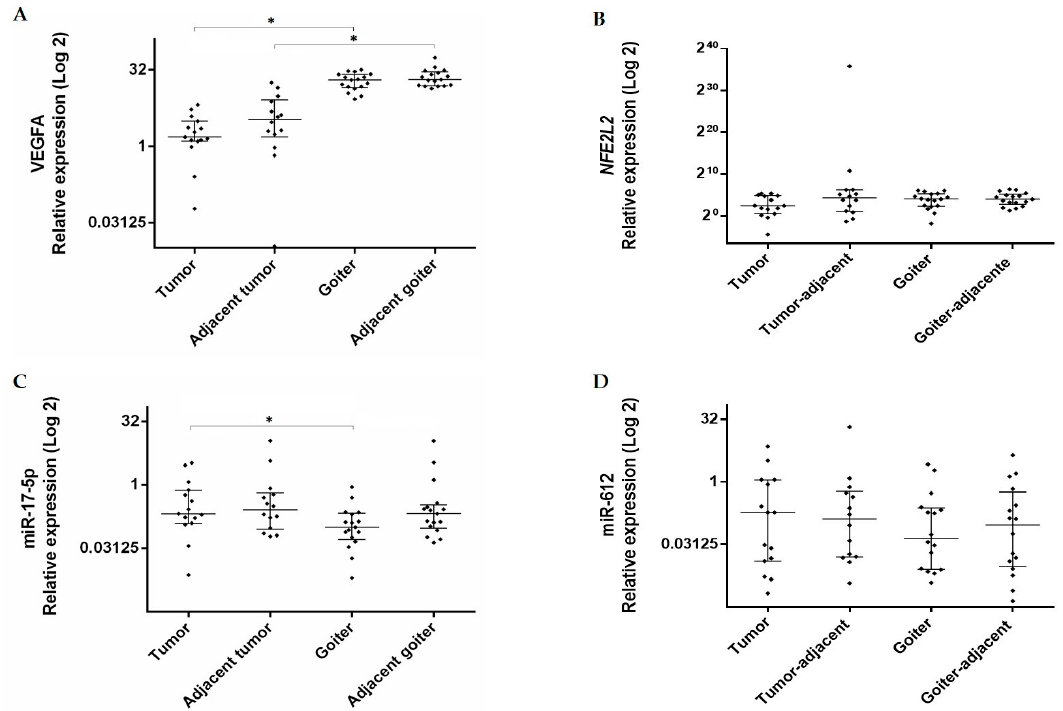
Figure 1. Expression levels of ( A ) VEGFA ( Vascular Endothelial Growth Factor A ), ( B ) NFE2L2 (Nuclear Factor (Erythroid-derived 2)-Like 2 ), ( C ) miR-17-5p, and ( D ) miR-612 in tumor and goiter tissues and their respective adjacent tissues. Data are presented as median with interquartile range (25% percentile and 75% percentile). The relative expression value was Log2 transformed ( y -axis). Calibrator (normal tissue) log RQ = 1. *, Statistically significant (panel A, Mann–Whitney, p < 0.0001; panel C, Mann–Whitney, p = 0.033).